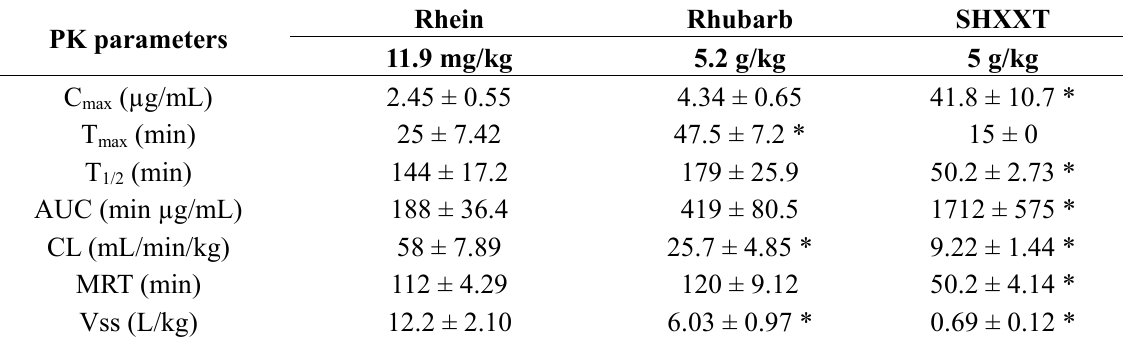
Table 5. Pharmacokinetic parameters of rhein after oral administration of rhein (11.9 mg/kg, p.o.), rhubarb (5.2 g/kg, p.o.), or SHXXT (5 g/kg, p.o.) to six